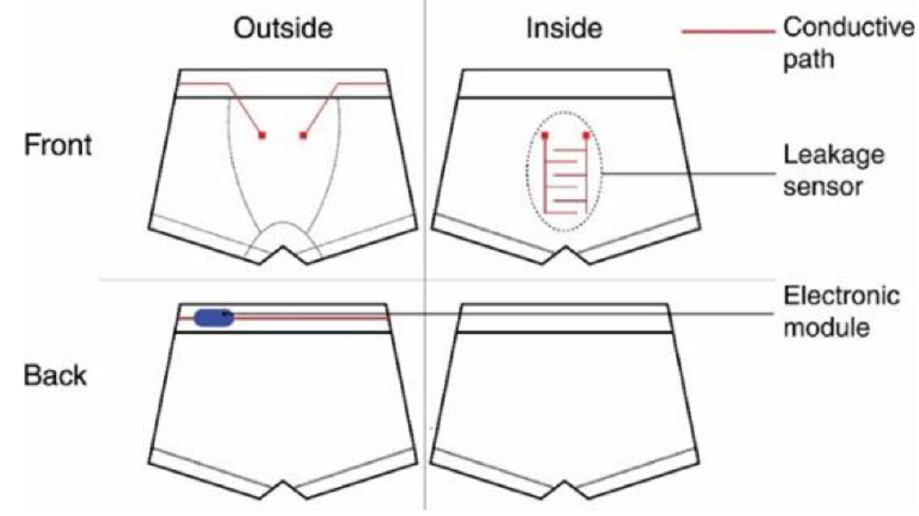
Figure 7. Scheme of the moisture-detecting underpants. From Reference [119], originally published under a CC-BY license.